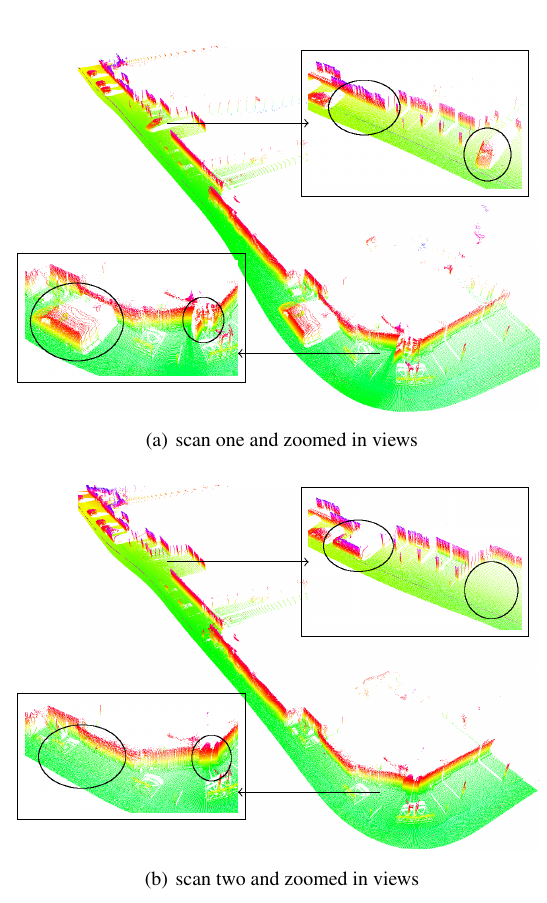
Figure 2: Two scans of test sites (coloured by height). In scan one, there was a van and a man changing the poster on the bill- board (lower right, site 1). None of these were present in scan two. On another site in scan one (upper left, site 2), there was a car coming out of the garage. In scan two, a van parked beside the pavement which was not there in scan